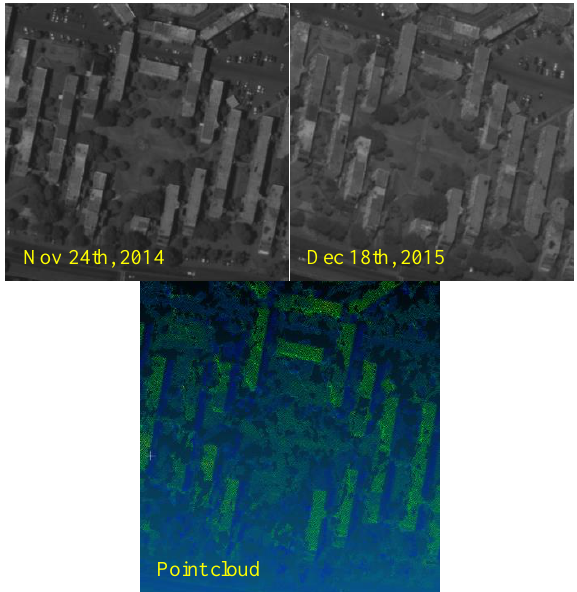
Figure 3. Images and point cloud from same season but different